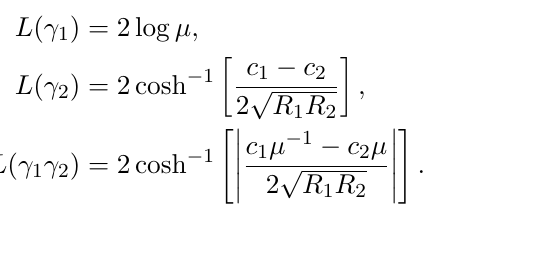
+ R 0 , c 0 − R 0 ] , A 0 = [1 , c 2 − R 1 ] ∪ [ c 1 + R 1 , µ 2 ] , A 0 = [ − µ 2 , c 0 1 1 2 2